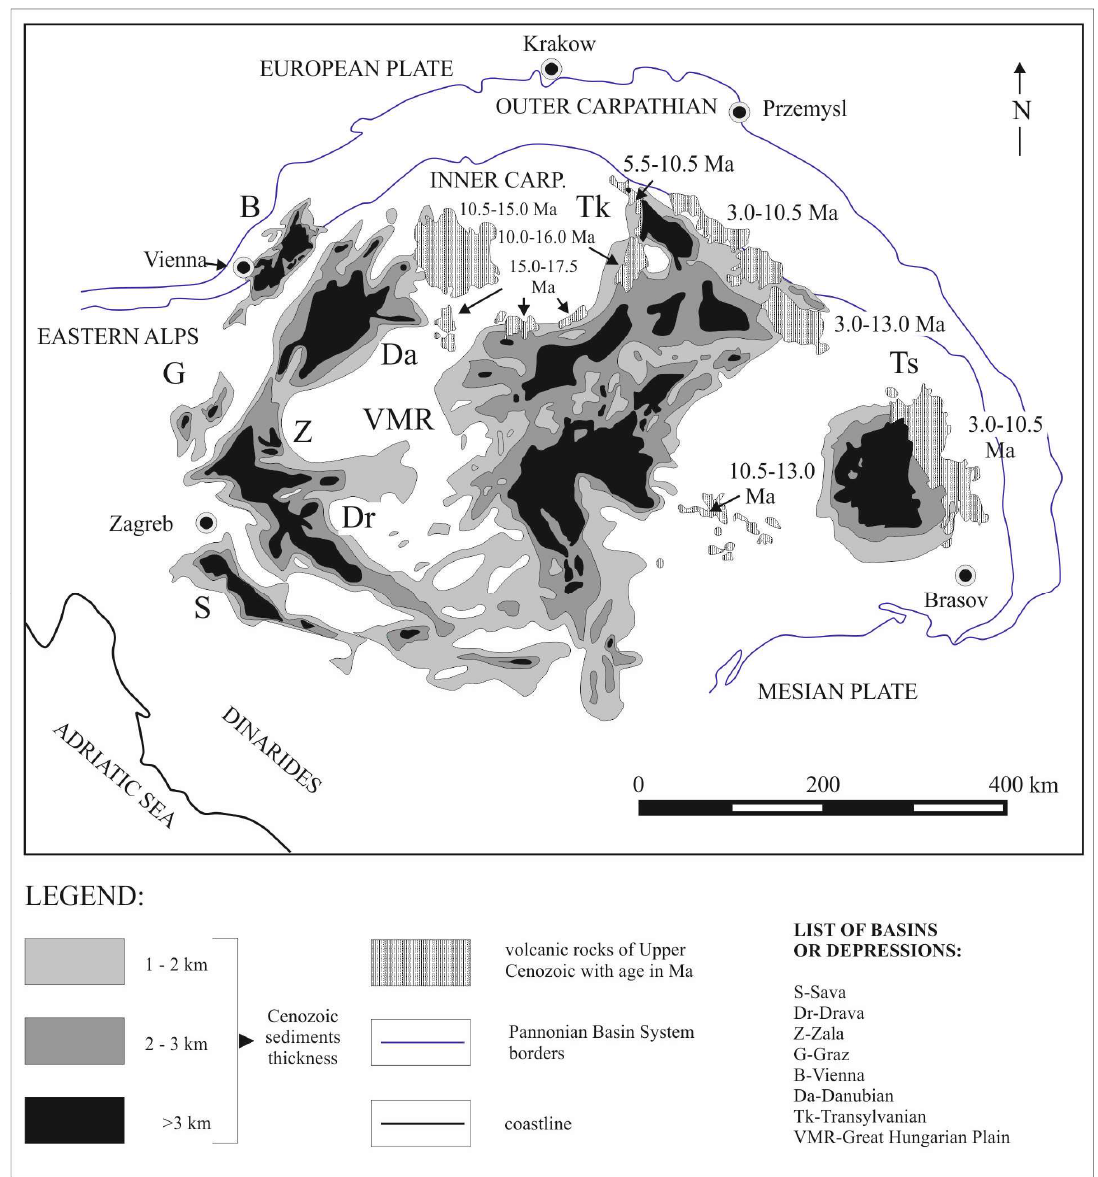
Figure 7. Location of the Croatian part within the Pannonian basin system / CPBS in the PBS